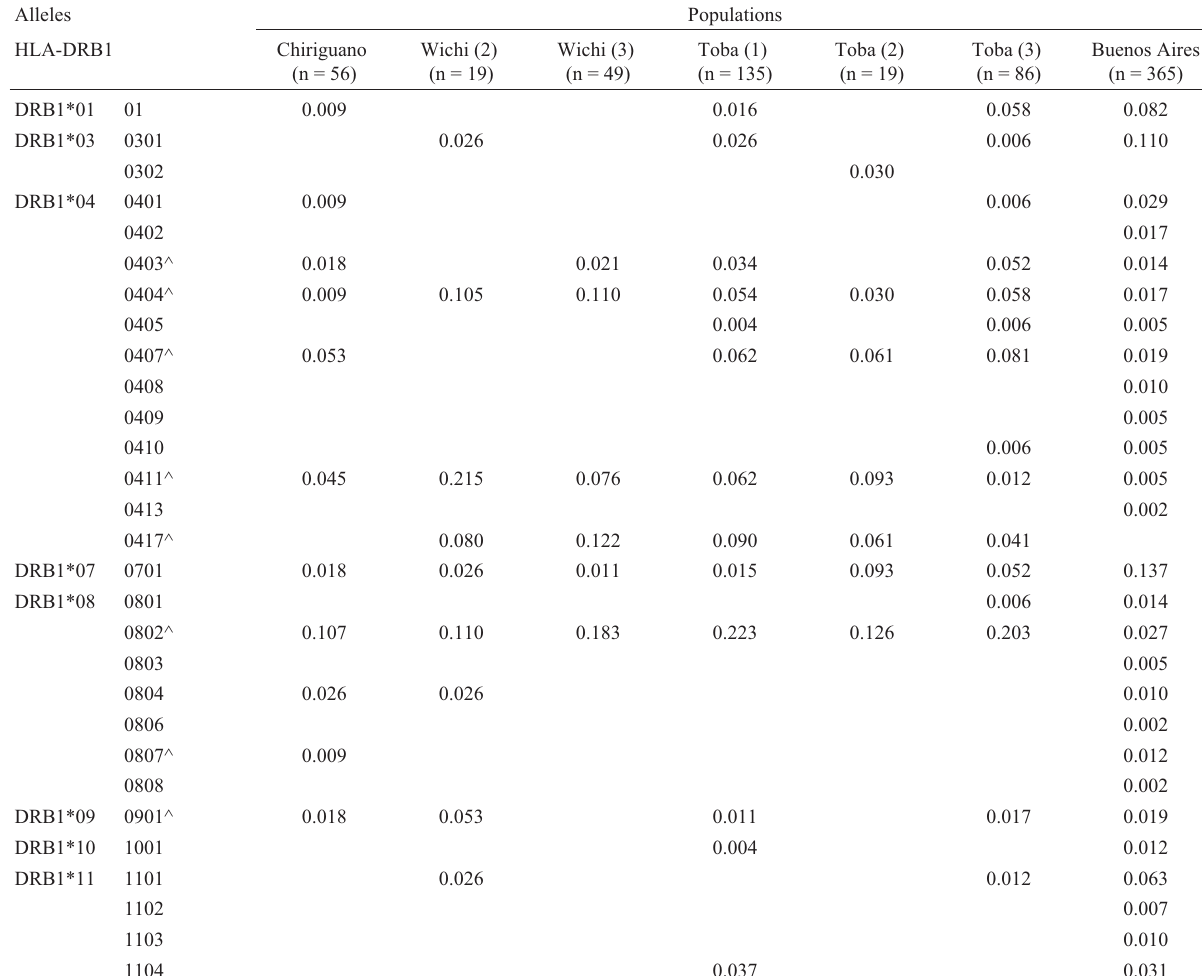
Table 3 - HLA-DRB1 allele frequencies in six Amerindian groups of the Gran Chaco and a sample of Buenos Aires city.